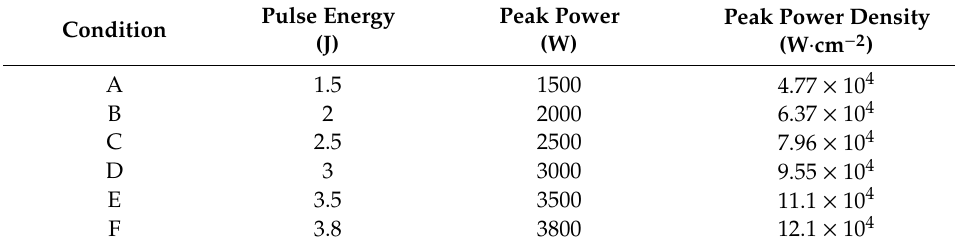
Figure 1. Experimental assembly of the laser ablation process. Table 1. The testing conditions for the laser ablation process.